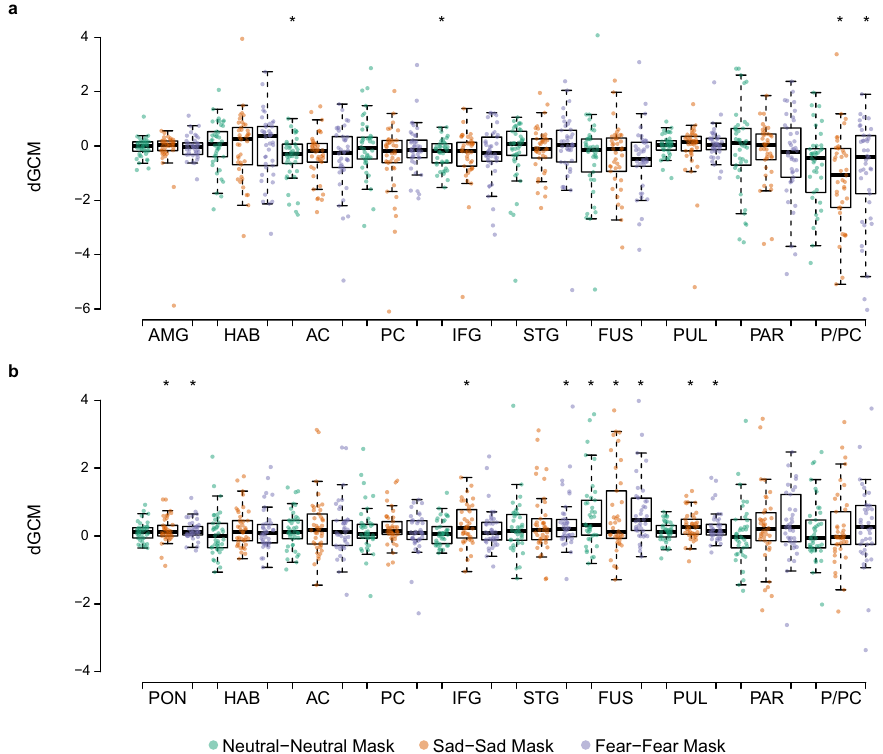
Fig. 4 Differential Granger causality map values extracted from each ROI. Extracted dGCM values from each ROI based on the map computed: a Pons as reference. b Amygdala as reference. All values tested against zero, * p FWE < 0.05. Whiskers: ±1.5 × interquartile range ( N = 41). AC anterior cingulate cortex; AMG amygdala, FUS fusiform; HAB habenula, IFG inferior frontal gyrus, PAR parietal, PC posterior cingulate cortex, PON pons, PUL pulvinar, P/PC precuneus/posterior cingulate cortex, and STG superior temporal